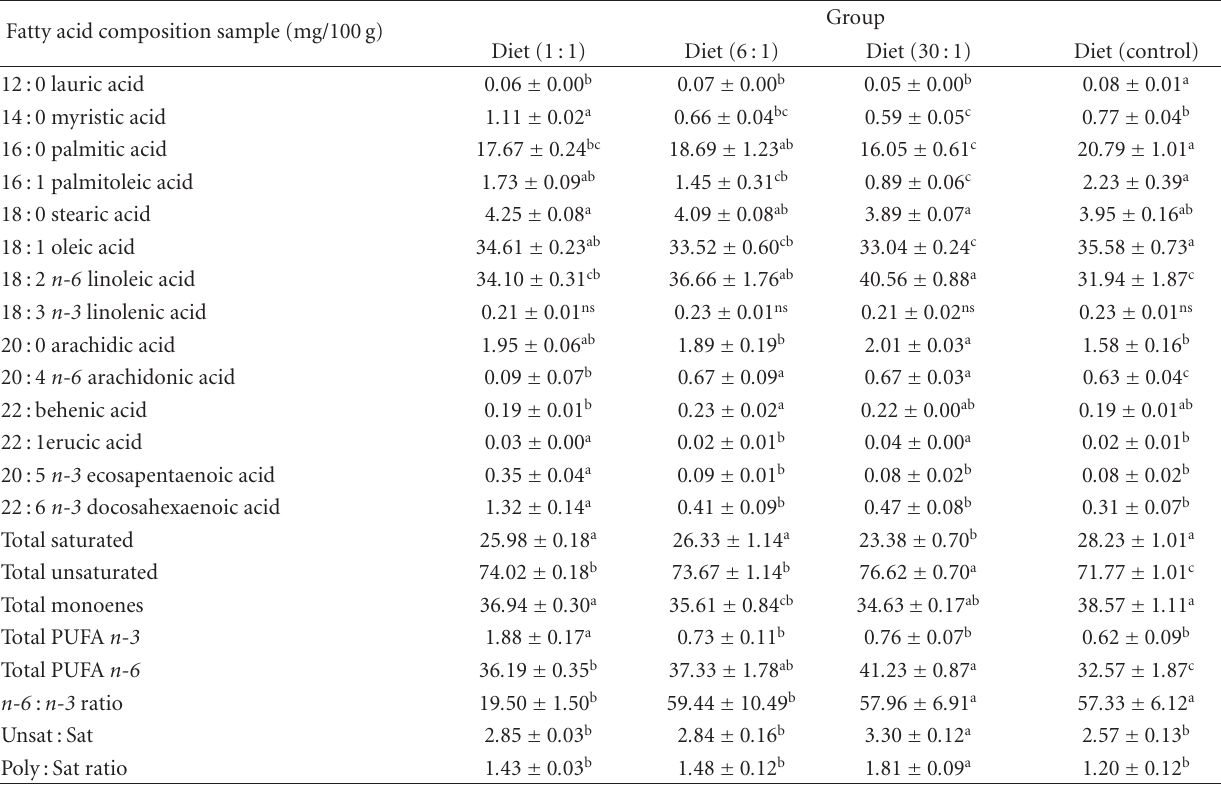
Table 4: Adipose tissue fatty acid composition (mg/100mL; Mean ± SE; n = 7) of rats from di ff rent treatment groups after 10 weeks of